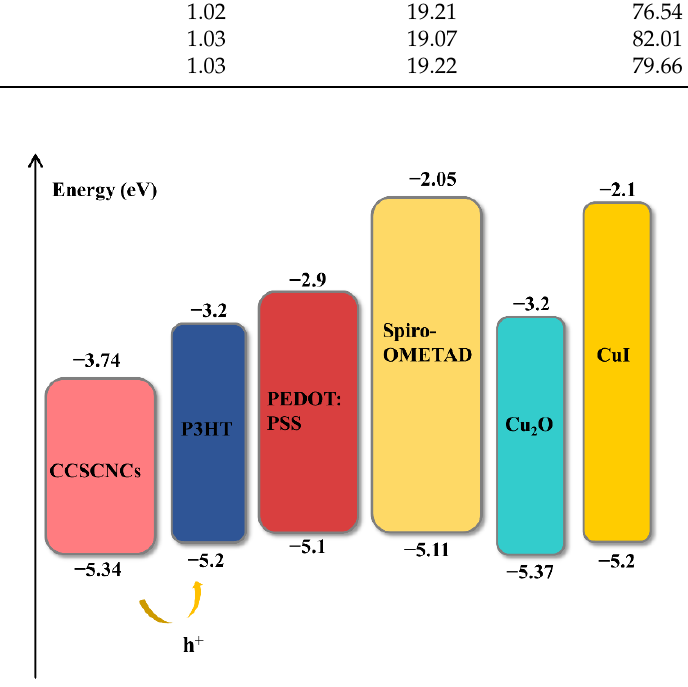
Figure 3. Band alignment between HTL materials and CCSCNCs. Table 4. Performance parameters of different HTMs as HTL.